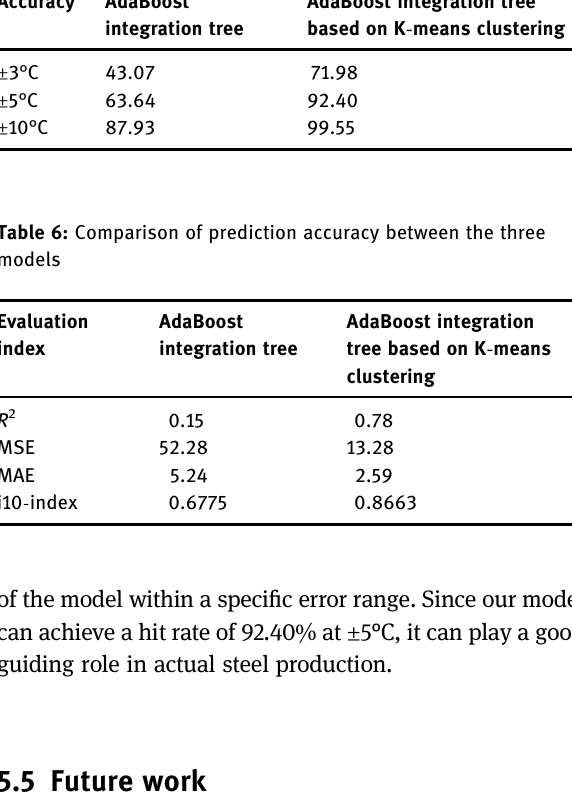
Table 5: Prediction accuracy between the three models/% Accuracy